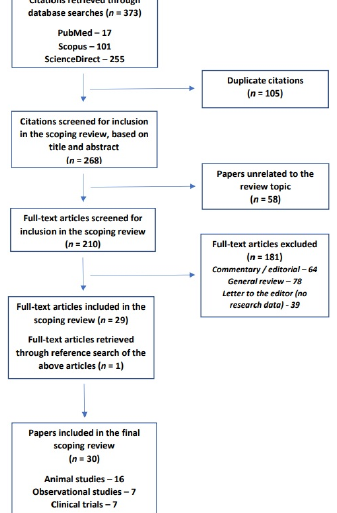
Figure 1. PRISMA ‐ ScR flow diagram for the current review. Figure 1. PRISMA-ScR flow diagram for the current